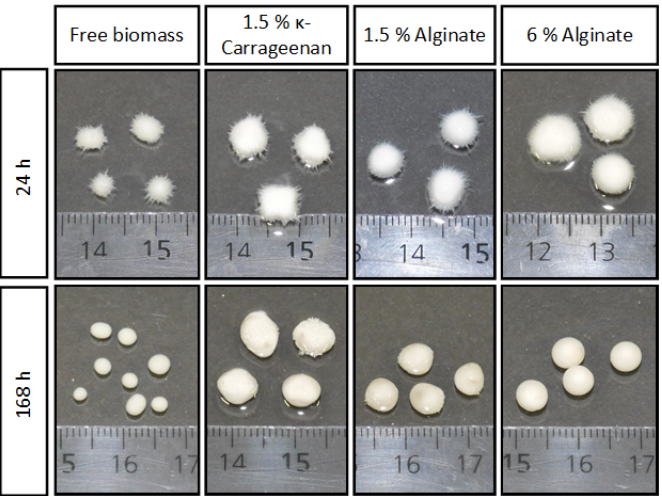
Figure 2. Appearance of free biomass pellets and immobilized A. oryzae during malic acid production in glucose medium.